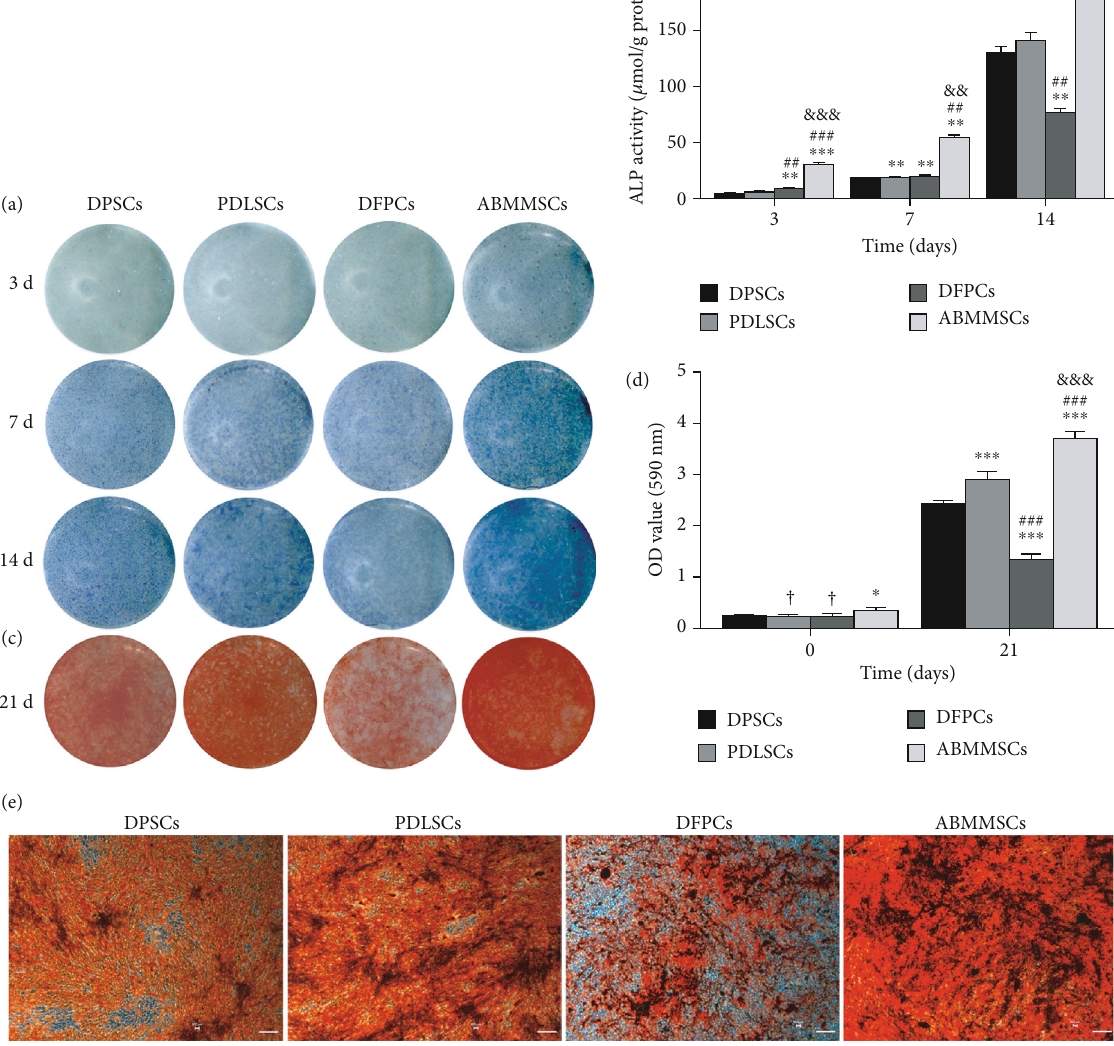
Figure 3: Osteogenic di ff erentiation staining of DPSCs, PDLSCs, DFPCs, and ABMMSCs. (a) ALP staining of DPSCs, PDLSCs, DFPCs, and ABMMSCs after 3, 7, and 14 days of osteogenic di ff erentiation ( n = 3 ). (b) ALP activity assay of DPSCs, PDLSCs, DFPCs, and ABMMSCs after 3, 7, and 14 days of osteogenic di ff erentiation ( n = 3 ). (c) Alizarin red staining of DPSCs, PDLSCs, DFPCs, and ABMMSCs after 21 days of osteogenic di ff erentiation ( n = 3 ). (d) Alizarin red staining for analysis of the calcium deposition amount of the DPSCs, PDLSCs, DFPCs, and ABMMSCs after 21 days of osteogenic di ff erentiation. ( n = 3 ). (e) Alizarin red staining of DPSCs, PDLSCs, DFPCs, and ABMMSCs after 21 days of osteogenic di ff erentiation ( n = 3 ) ( scale bar = 2 mm) ( ∗ p < 0 : 05 , ∗∗ p < 0 : 01 , and ∗∗∗ p < 0 : 001 vs. DPSCs; # p < 0 : 05 , ## p < 0 : 01 , and ### p < 0 : 001 vs. PDLSCs; & p < 0 : 05 , && p < 0 : 01 , and &&& p < 0 : 001 vs. DFPCs; † p < 0 : 05 , †† p < 0 : 01 , and ††† p < 0 : 001 vs.